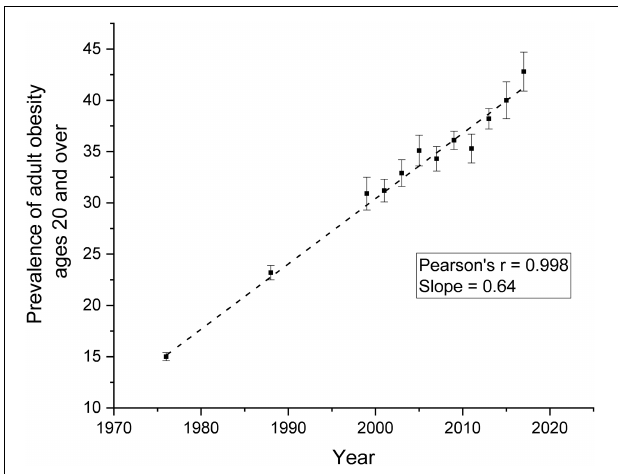
FIGURE 1 | Prevalence of Overweight, Obesity, and Severe Obesity Among Adults Aged 20 and Over: United States, 1960–1962 Through 2017–2018